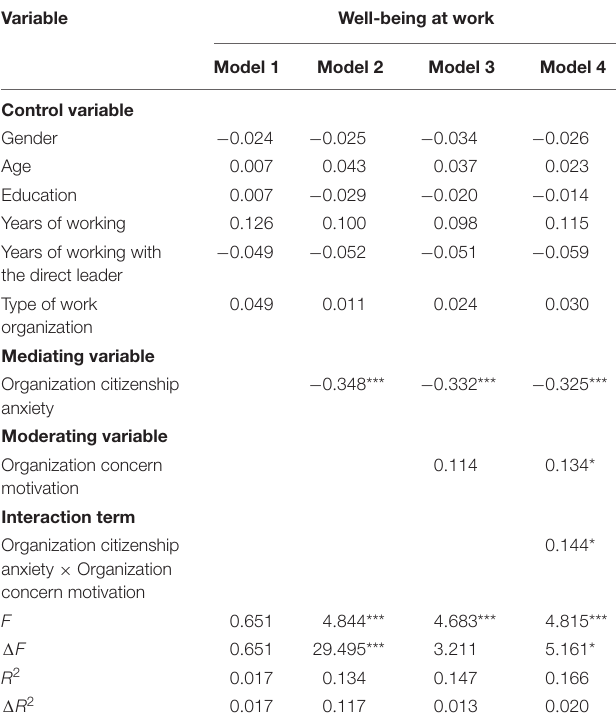
TABLE 4 | The moderating effect of organizational concern motivation.